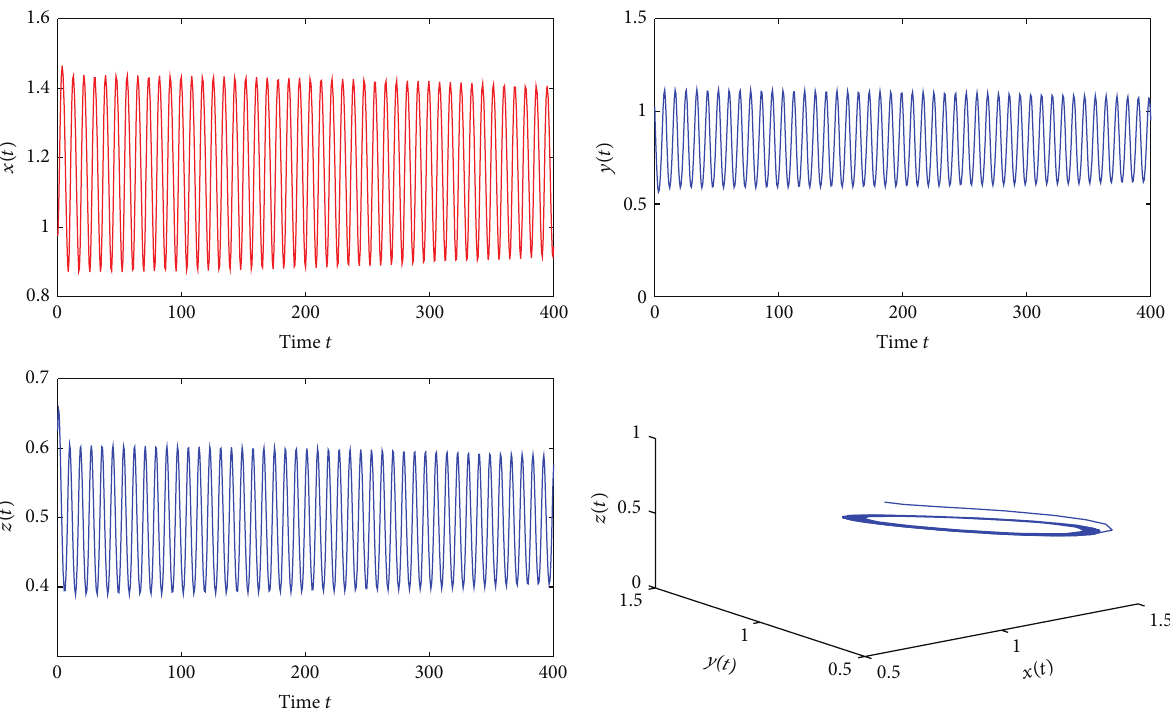
Figure 2: 𝐸 ∗ is unstable for 𝜏 1 = 1.498 > 𝜏 10 = 1.4887 with initial values 0.975, 1.025, and